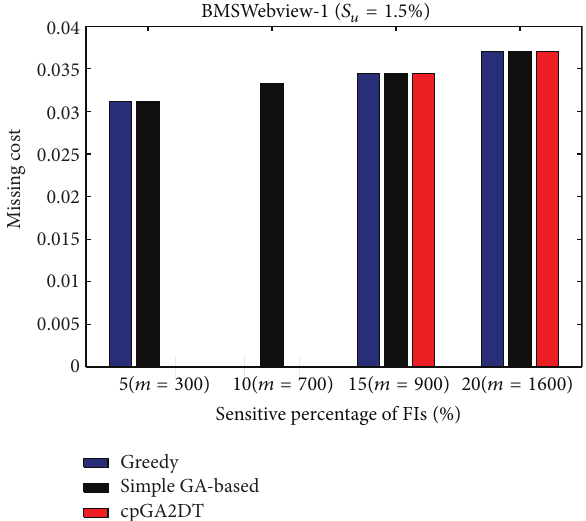
Figure 17: Comparisons of hiding failure at various minimum support thresholds for BMSWebview-1 database.